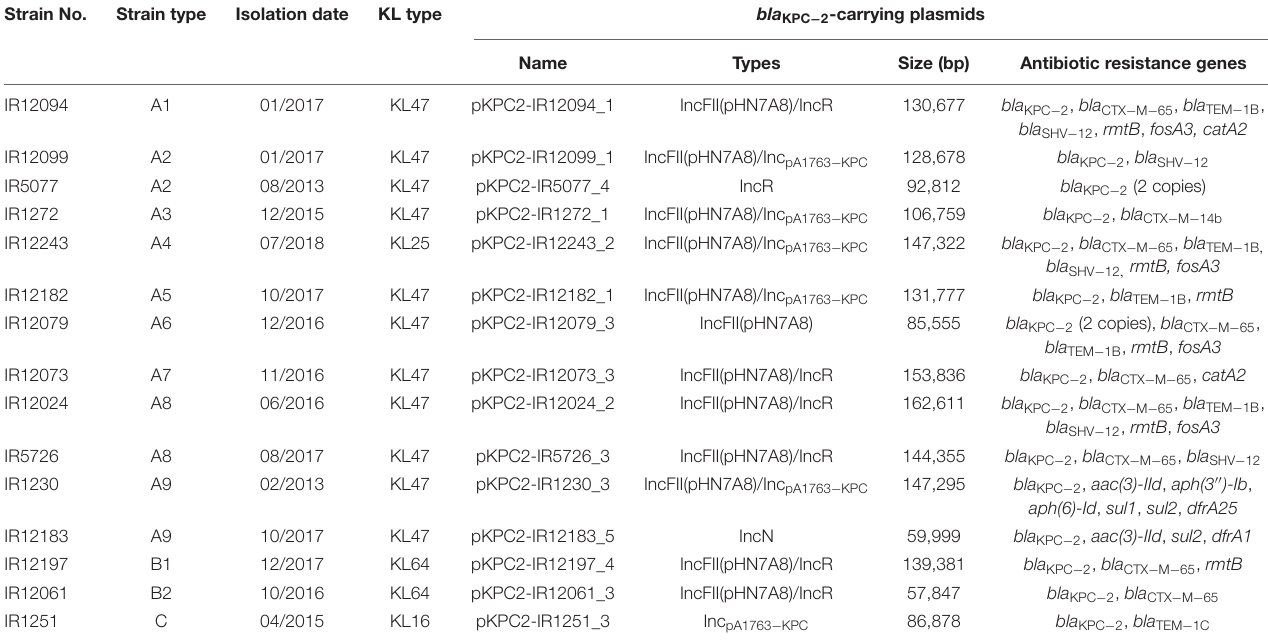
TABLE 1 | Characteristics of bla KPC − 2 -carrying plasmids. Strain